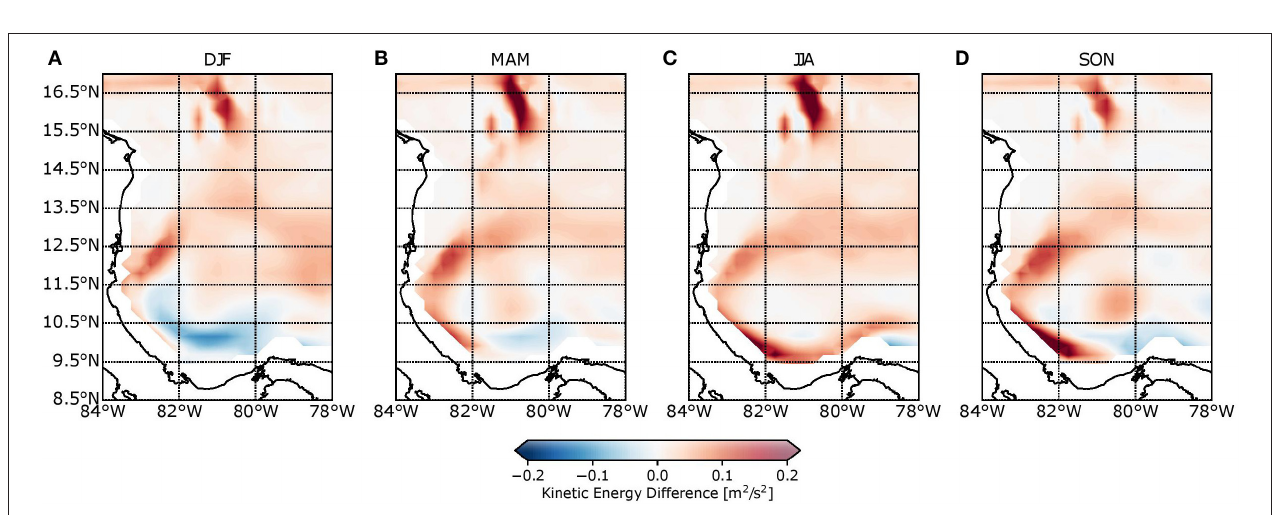
FIGURE 4 | Seasonal kinetic energy difference between model and AVISO satellite data for (A) December–January–February, (B) March–April–May, (C) June–July–August, and (D) September–October–November. Red coloration is associated with kinetic energy overestimation, while blue coloration is associated with its